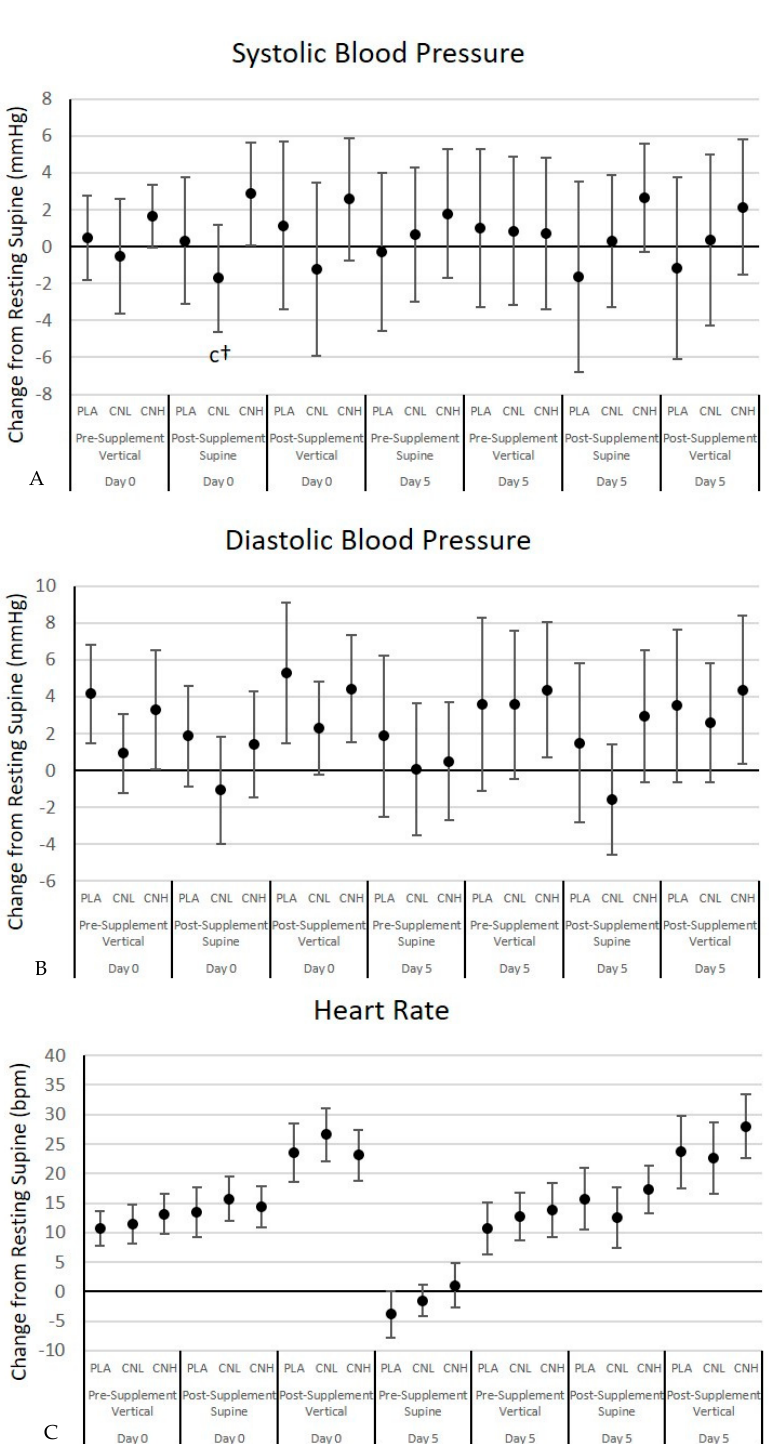
Figure 4. Systolic blood pressure ( A ), diastolic blood pressure ( B ), and heart rate ( C ) responses from to the postural hemodynamic challenge test from baseline values for the placebo (PLA), low dose creatine nitrate (CNL), and high dose creatine nitrate (CNH) treatments. Data are mean changes (95% CI). Confidence intervals not crossing zero are statistically significant ( p < 0.05). c Represents p < 0.05 difference from CNH. † Represents p > 0.05 to p < 0.05 effect.